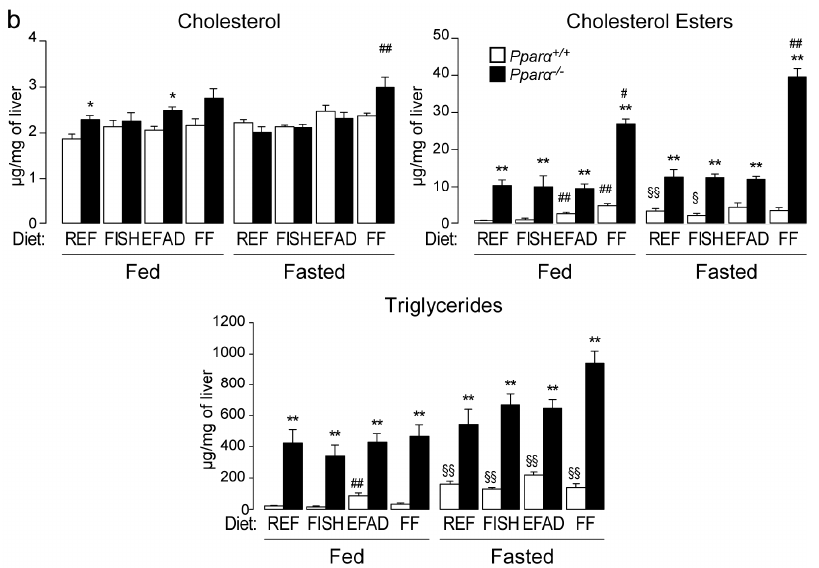
Figure 3. Effect of dietary fat on liver steatosis. Wild-type ( Ppar α +/+ ) and total Ppar α knockout ( Ppar α − / − ) mice were fed ad libitum or fasted for 24 h and then euthanized at ZT14. ( a ) Representative pictures of Oil-Red-O stained liver sections. Scale bars = 100 µm. Histological scoring was performed and is noted in the top right of each picture; ( b ) quantification of total cholesterol, cholesterol esters, and triglycerides in the liver by gas chromatography. n = 6–8 mice/genotype/diet. Data represent mean ± SEM. * Significant genotype effect, # significant diet effect, § significant effect of fasting. *, # , § p ≤ 0.01. **, ## , §§ p ≤ 0.001. REF: standard diet; FISH: diet enriched in n-3 essential fatty acids from